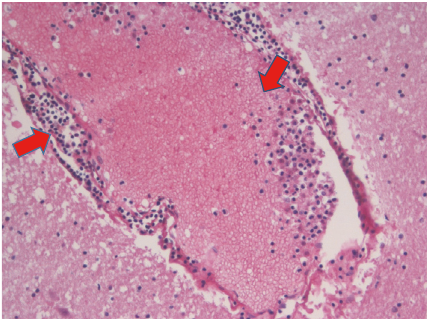
Figure 4: Venular occlusion by erythrocytes, promyelocytes, and myelocytes (arrows) (H & E, ∗ 20).